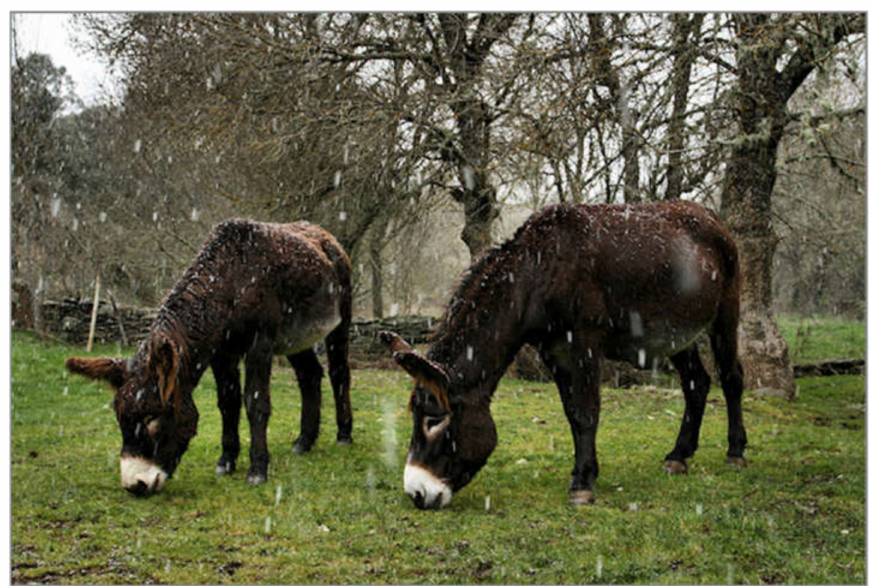
Figure 2. Morphological characteristics of the autochthonous Miranda do Douro Donkey breed. Grazing animals at a rehabilitation center (Source: AEPGA).